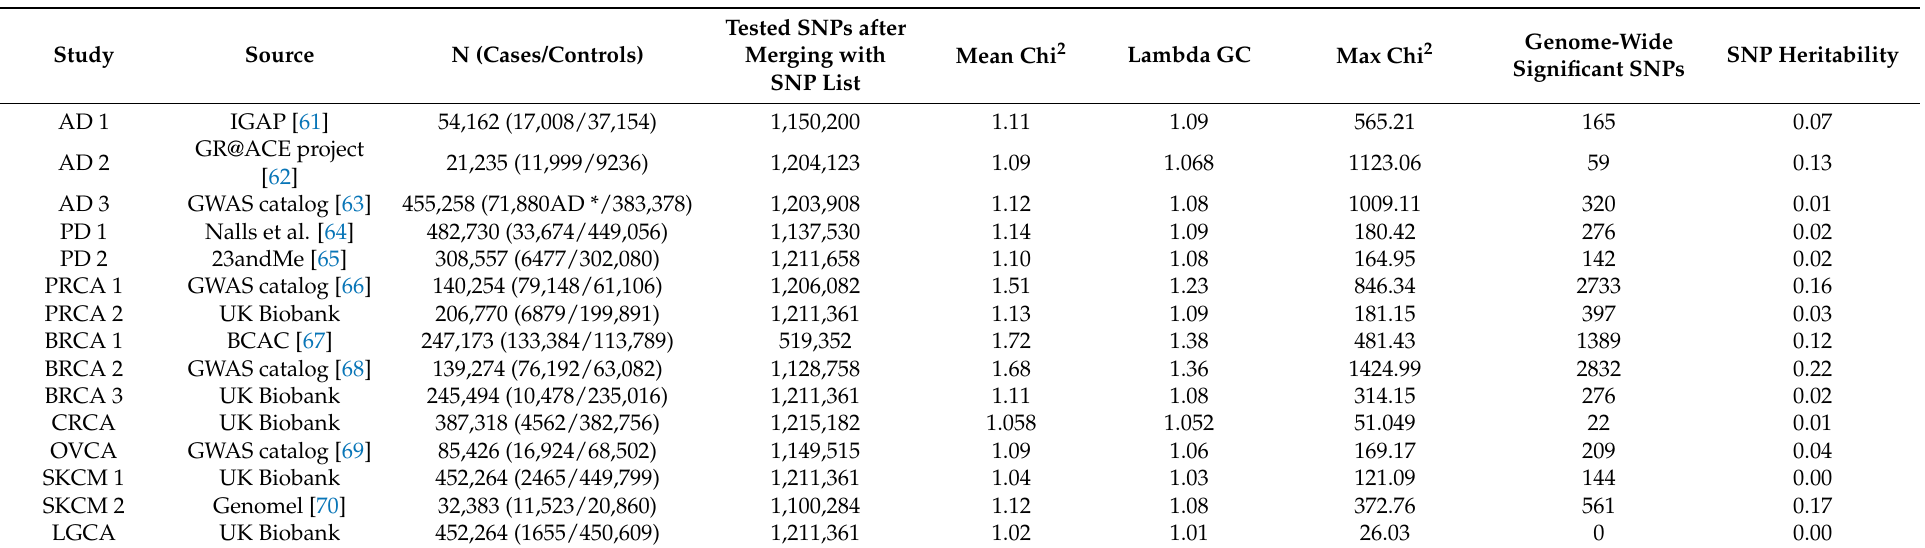
Table 2. Characteristics of the studies included in the genetic correlation